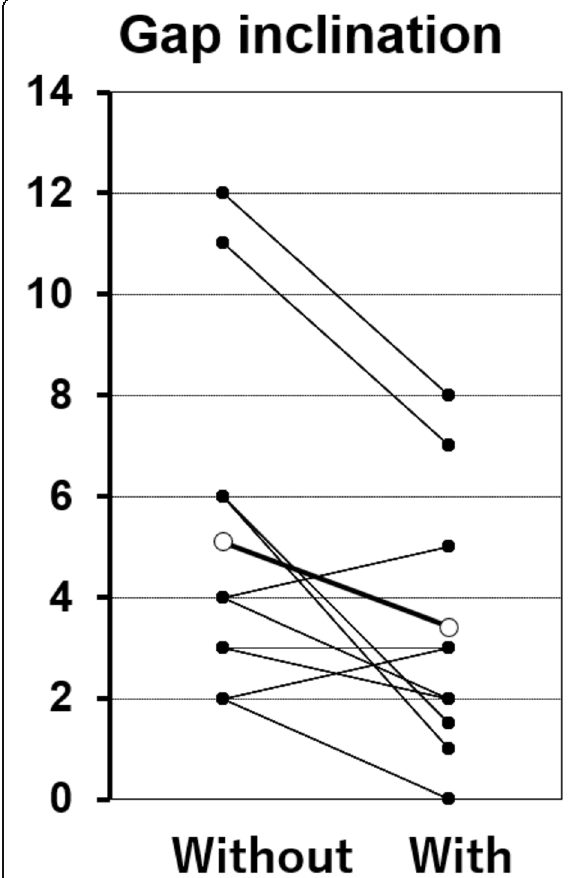
Fig. 4 Gap inclination. The gap inclination during 90° flexion without (left) and with (right) the trial component. ( ○ : mean gap